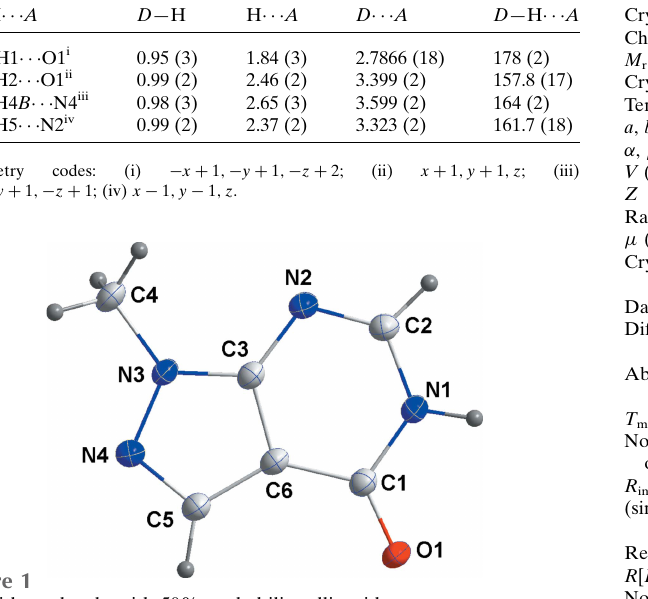
Table 2 Experimental details.